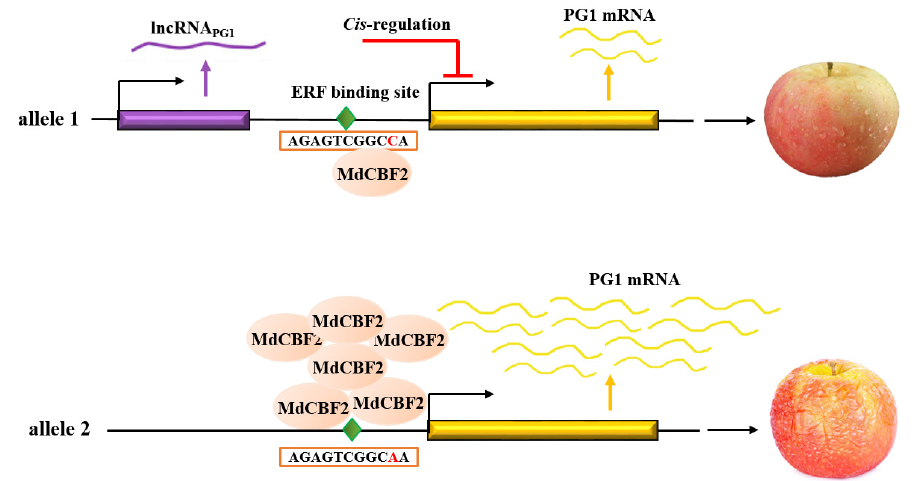
Figure 6. Proposed mechanism of MdPG1 allele-specific expression in apple fruit softening. MdCBF2 directly bind to the promoter of the SNP A allele of MdPG1 to enhance MdPG1 expression. lncRNA PG1 suppresses MdPG1 mRNA level through a cis -regulation mechanism. The diamond represents an ERF-binding element.